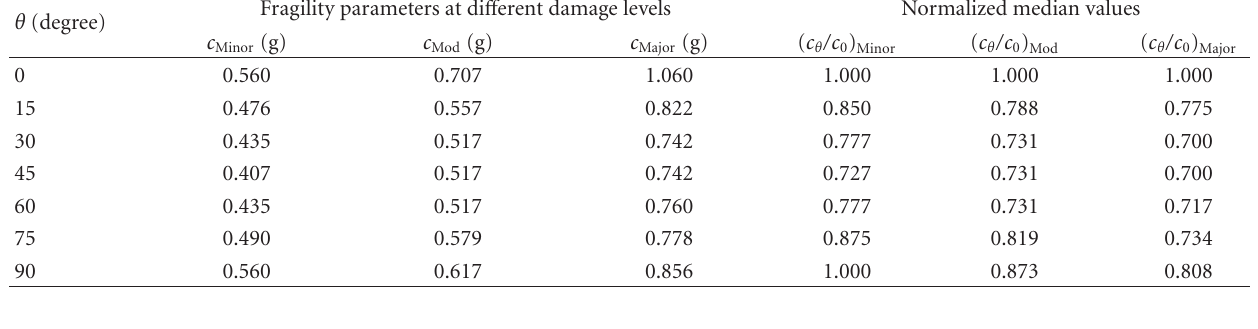
Table 4: Fragility parameters of the bridge at di ff erent θ for one component of ground motion (case II). θ (degree)